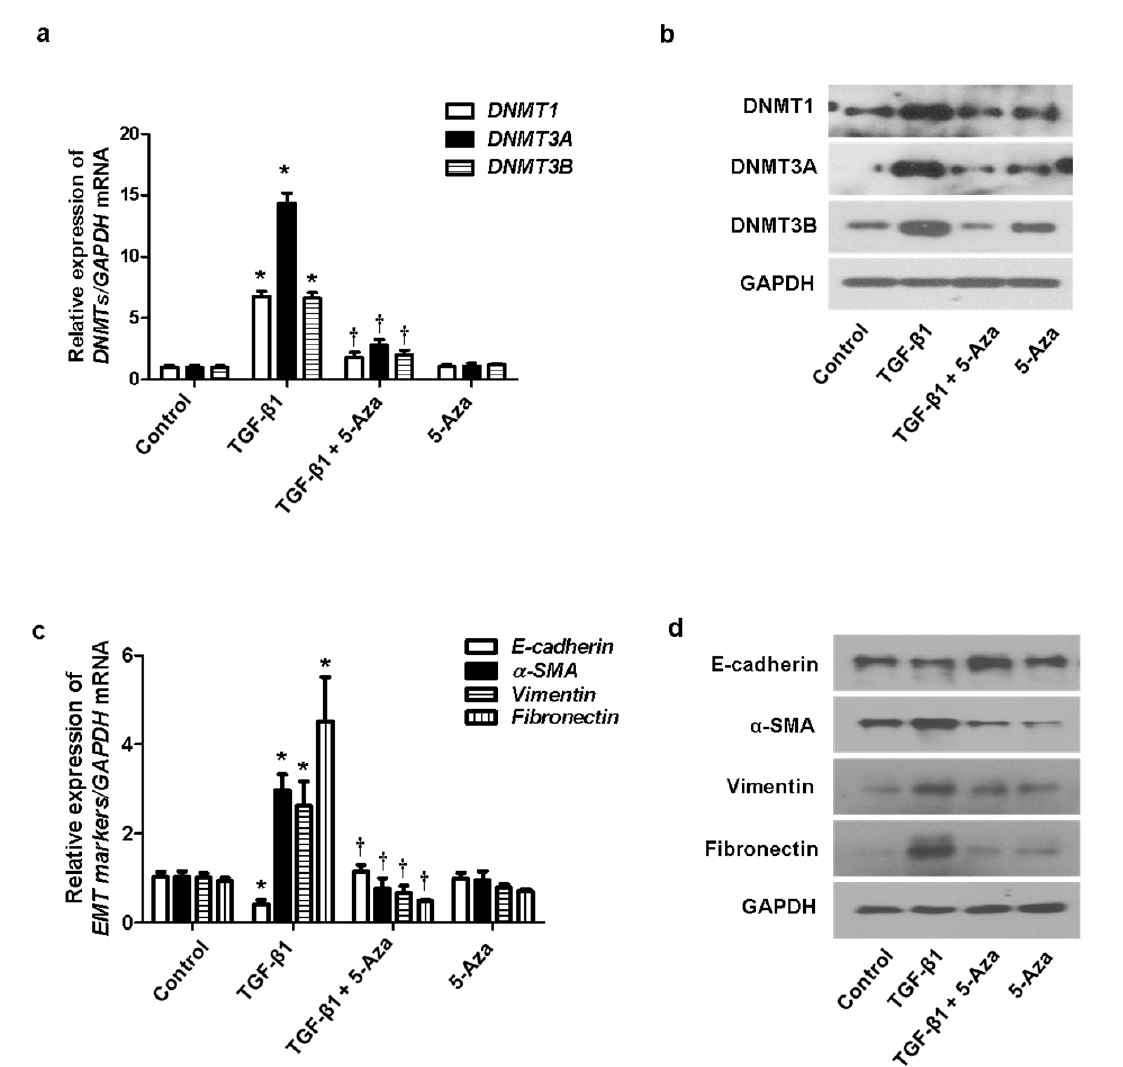
Figure 3. Effect of 5-Aza on EMT induced by TGF- β 1 in A549 cells. A549 cells were stimulated with TGF- β 1 (5 ng/mL) with or without the DNMT inhibitor (5-Aza, 10 µ M): ( a ) the mRNA expression levels of DNMT1, DNMT3A, and DNMT3B were determined using RT–PCR; ( b ) protein expression levels of DNMT1, DNMT3A, and DNMT3B were measured using Western blotting; ( c , d ) effects of 5-Aza on the mRNA and protein levels of E-cadherin, vimentin, α -smooth muscle actin protein, and fibronectin expression in TGF- β 1-stimulated A549 cells as determined using RT–PCR and Western blotting. Data are expressed as the mean ± SEM of three independent experiments. Values are expressed as the mean ± SEM of three independent samples using a single A549 cell line. * p < 0.05 vs. control; † p < 0.05 vs. TGF- β 1 alone.